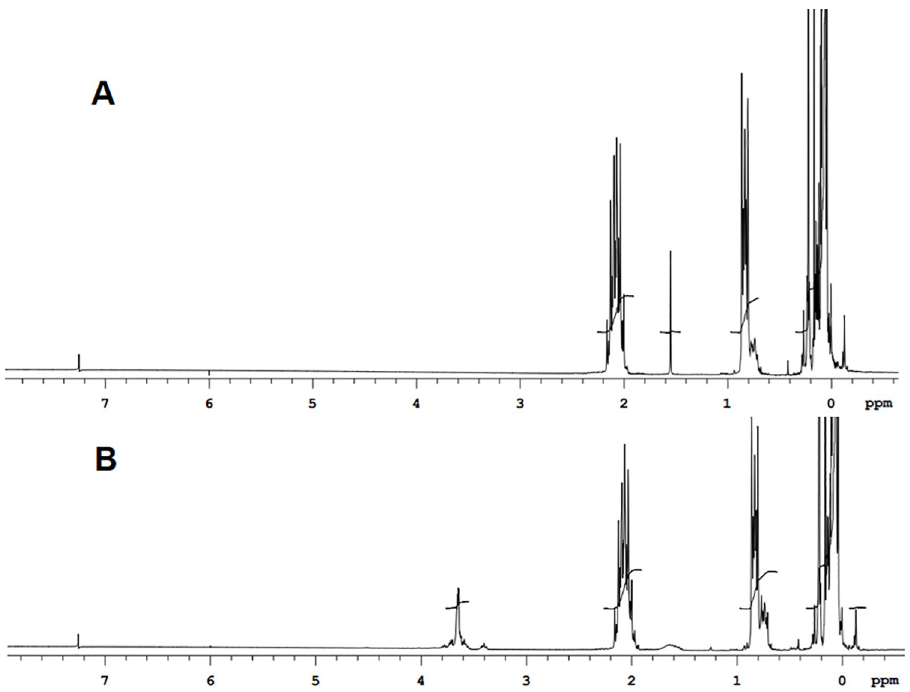
Fig 8. 1 HNMR overlays showing the presence of the surfactant with the Pr f hydrophobe CF 3 CH 2 CH 2 - dissolved in the low molecular weight fluid (fluid B). (A) 1 HNMR of the fluid without surfactant. (B) 1 HNMR of a 4% (v/v the fluid with surfactant.A single peak that comes from the C F 3 CH 2 CH 2 - from the fluorinated fluid. The characteristic signals of the -(CH 2 CH 2 -O)- can be observed at 3.4–3.8 ppm.